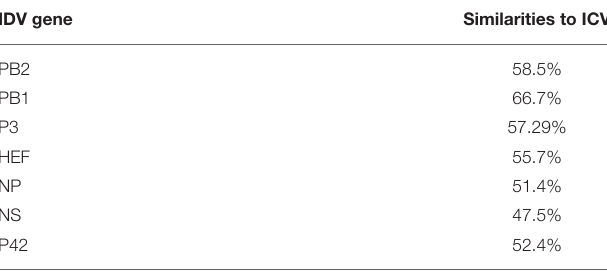
TABLE 3 | IDV similarities to ICV IDV shares 50% amino acid sequence identity with ICV, lacks the neuraminidase gene, and has seven genes instead of eight seen in IAV and IBV